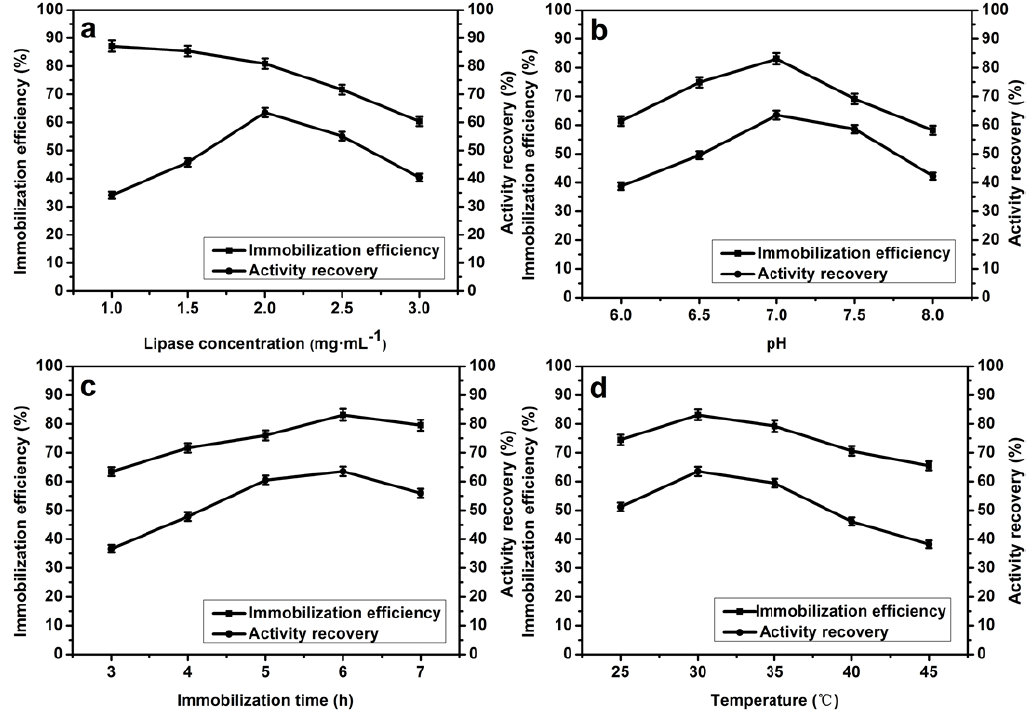
Figure 9. Influence of lipase concentration ( a ), pH ( b ), immobilization time ( c ), and immobilization temperature ( d ) on the immobilization efficiency and activity recovery. Other immobilization conditions, as follows: Immobilization temperature, 30 °C; lipase concentration, 2 mg·mL −1 ; pH, 7.0; and immobilization time, 6 h.